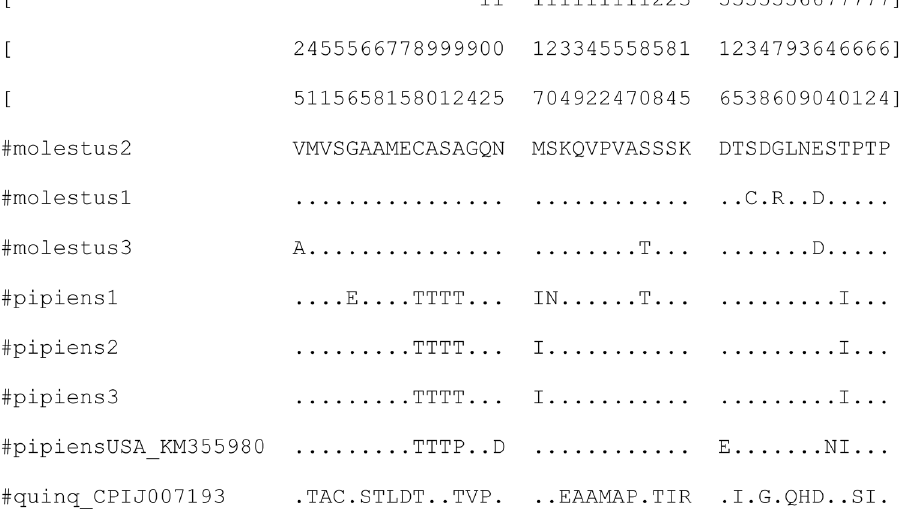
Figure 1. Variable amino acid sites of the gene period in C. pipiens . C. pipiens from the USA (KM355980) and C. quinquefasciatus (CPIJ007193) are taken for the comparison. Exons 2 (sites 1-111), 3 (113-358), and 4 (360-768) are separated with blank columns. Positions of the variable sites relative to combined sequences as presented in Suppl. material 1 shown on the Table 2. Estimates of Evolutionary Divergence over per and tim sequence pairs between Culex pipiens complex members.